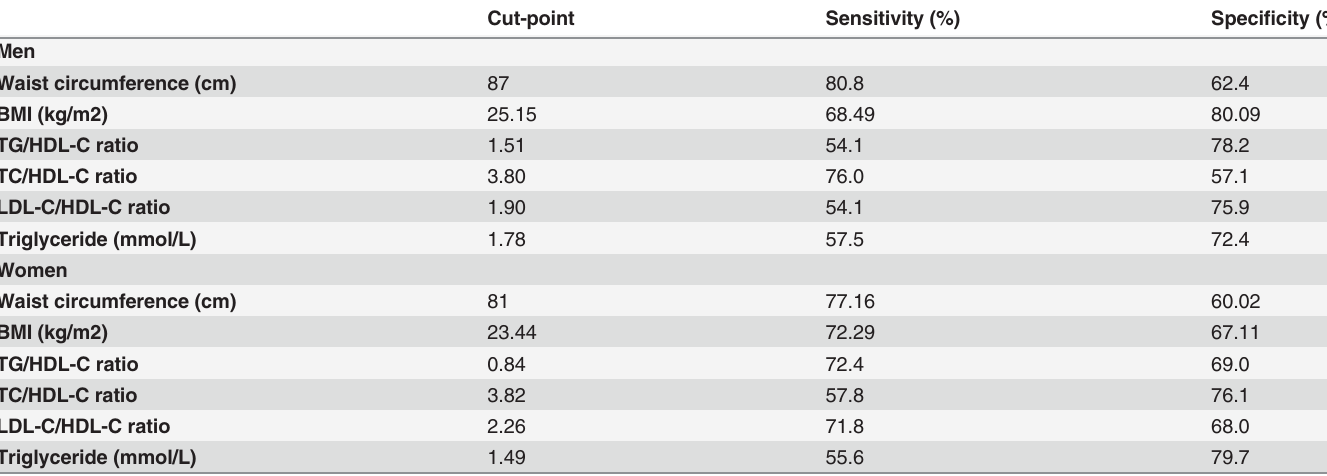
Table 4. Optimal cut-offs for lipid ratios and the associated sensitivities and speci fi cities a